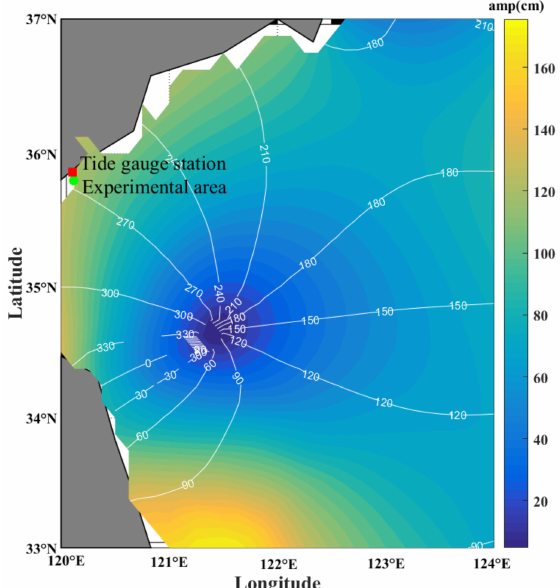
Figure 6. Cotidal chart of the M 2 tide constituent. The white solid lines indicate the co-phase lines with an interval of 30 ◦ , and different colors in the ribbon represent the co-amplitude lines. The positions of the tide gauge station and experimental area are